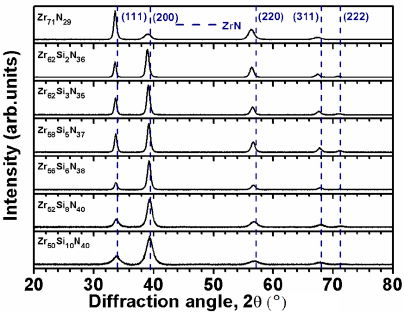
Figure 5. Grazing ‐ incident X ‐ ray diffraction (GIXRD) patterns of Zr–Si–N films prepared using various RF powers on Si target.